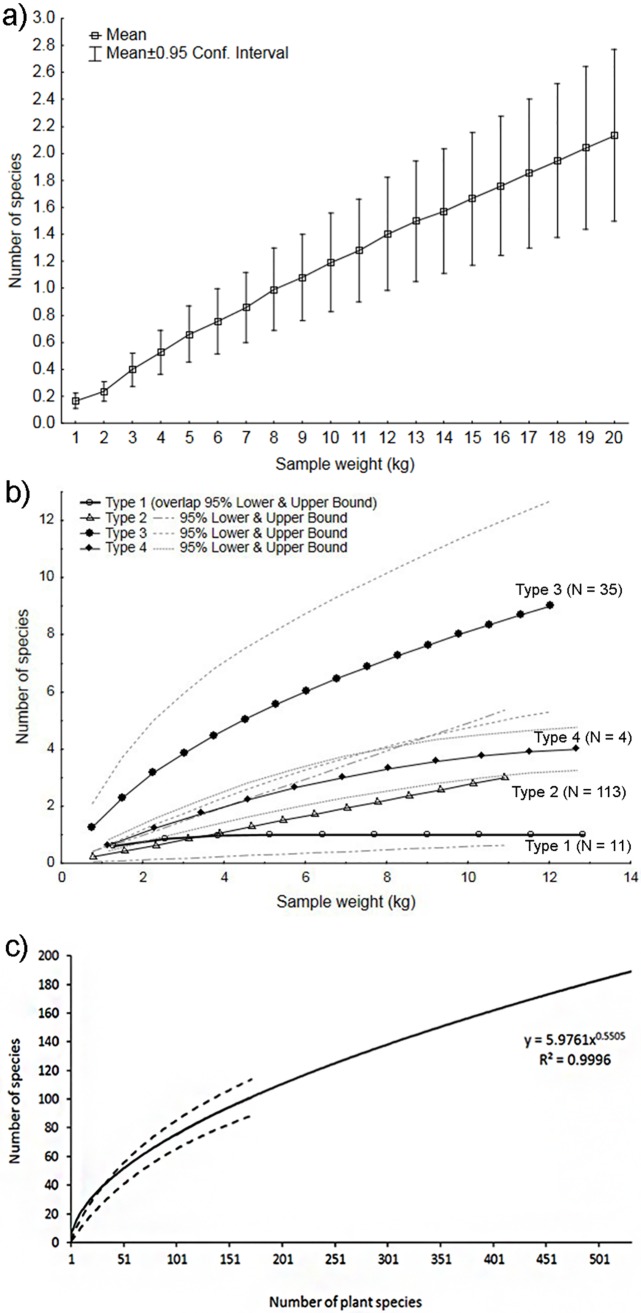
Species accumulation curves for Lepidoptera as functions of sample size.(a) Mean number of lepidopteran species as a function of fruit sample weight for a subset of 33 plant species with sufficiently large samples (1 to 20 kg). (b) Mean number of lepidopteran species per host plant species as a function of fruit sample weight. Confidence intervals (95%) are shown for each of four types of accumulation curve. The number of plant species (N) comprising each curve is also shown. (c) Species richness of Lepidoptera as a function of plant species richness for 163 attacked plant species.